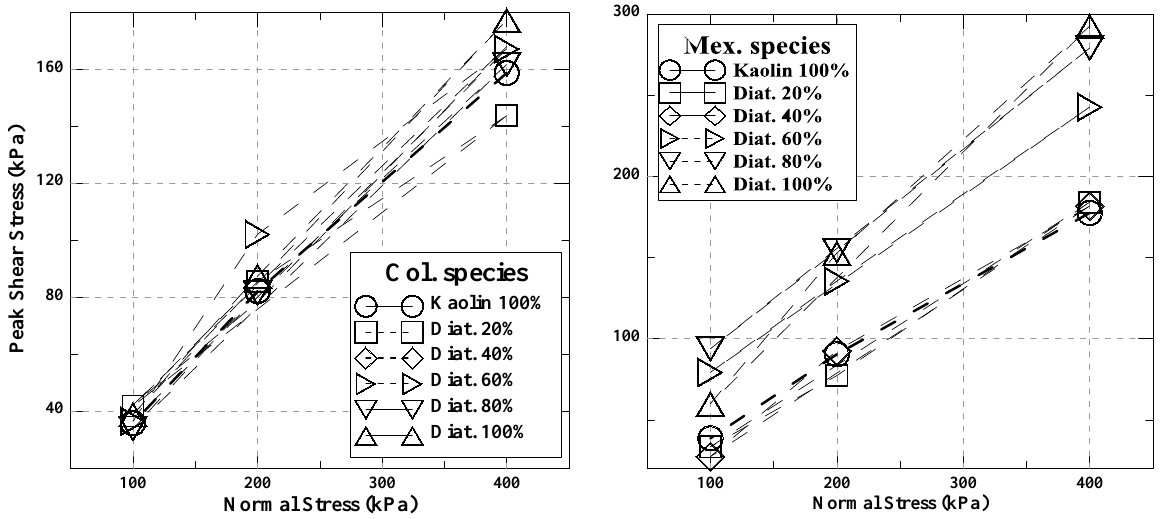
Figure 7. Relationship between peak shear stress vs. normal stress at different diatom contents.